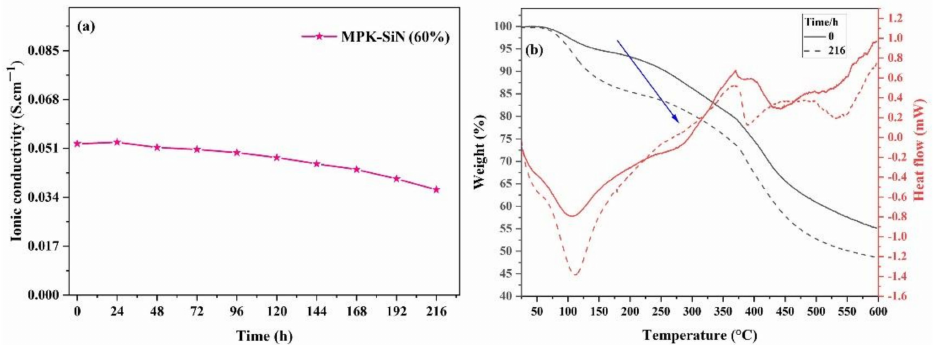
Figure 4. Ionic conductivity of MPK–SiN (60%) at room temperature with increasing immersion times in alkaline solution ( a ); TGA and DTGA profile of MPK–SiN (60%) before (0 h) and after 216 h of treatment in alkaline solution ( b ). The arrow indicates the weight